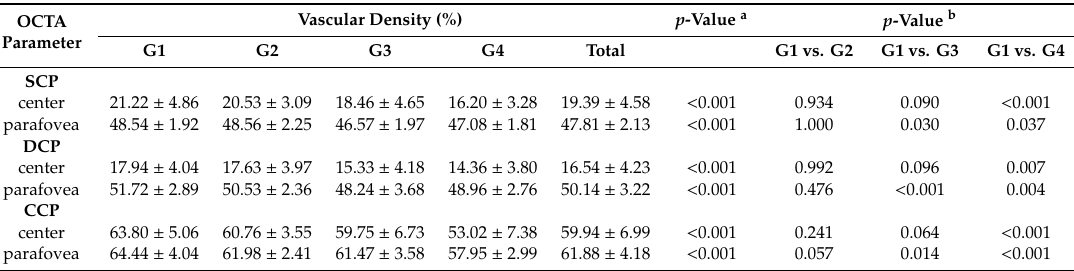
Table 3. Vascular density measurements by age groups.